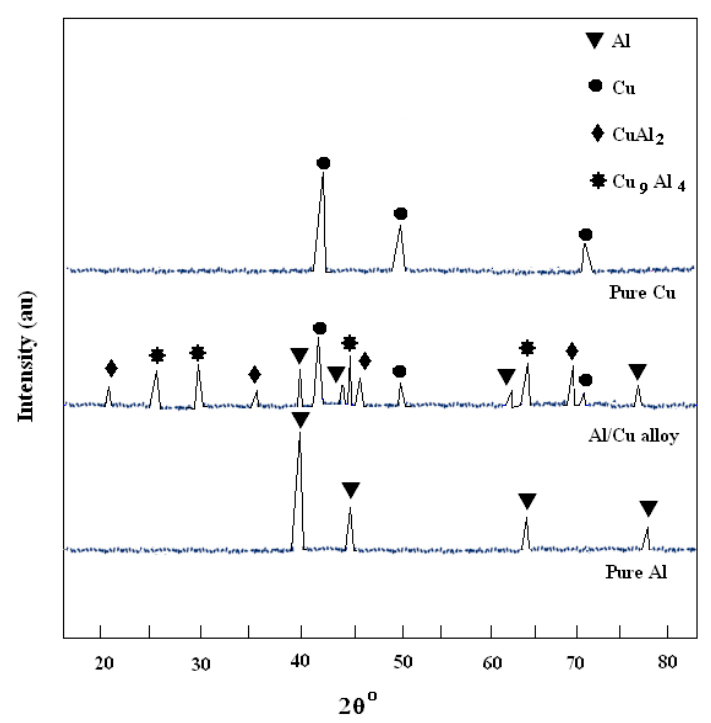
Figure 5. XRD diffractogram of the Al, Cu and Al/Cu alloy. Figure 5. XRD di ff ractogram of the Al, Cu and Al / Cu